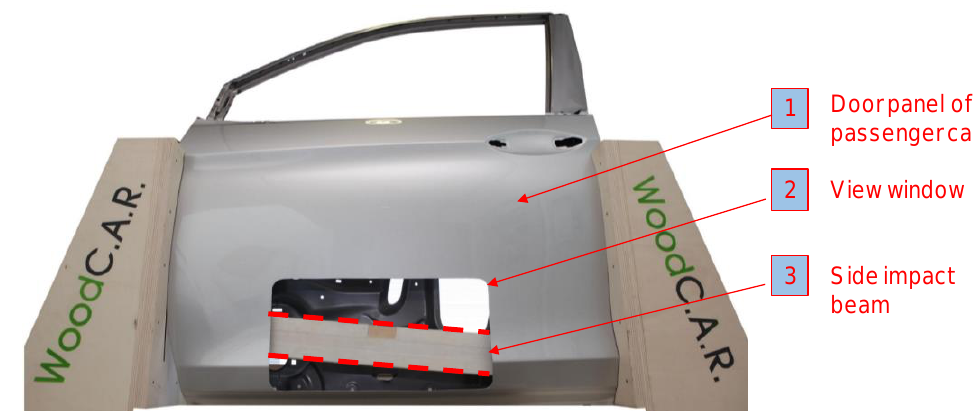
Figure 2. Demonstrator of a passenger car door panel with an integrated side-impact beam.